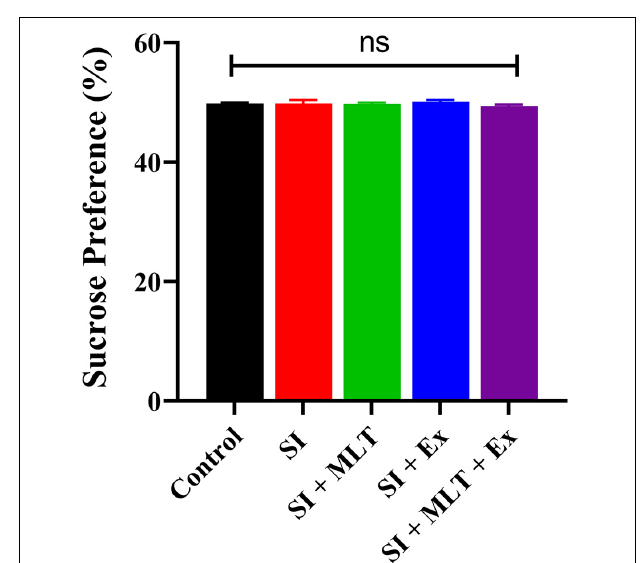
FIGURE 6 | The effect of MLT and Ex on SPT performance (%) among groups. Data are presented as mean ± SEM. One-way ANOVA was used. ns,